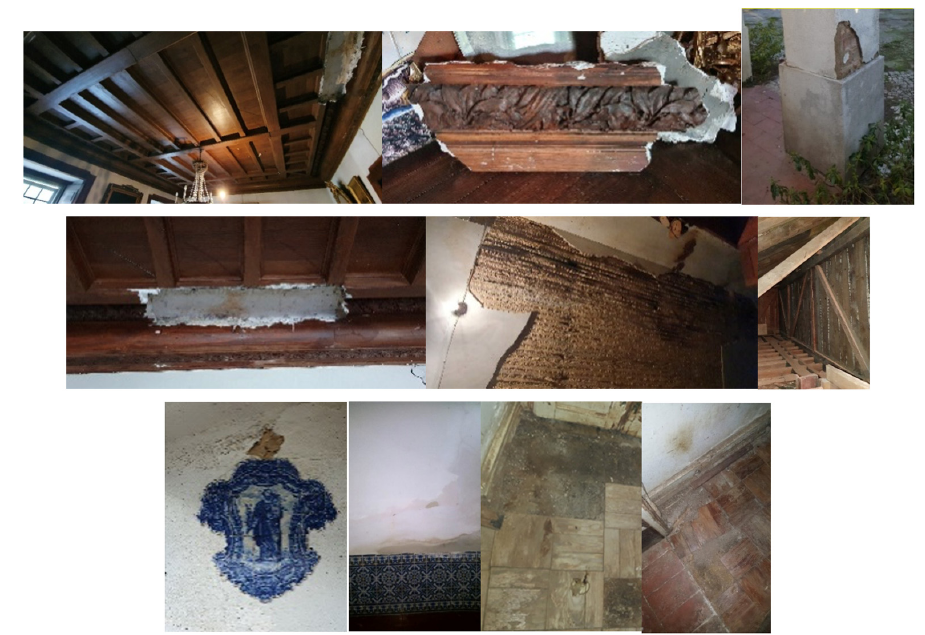
Figure 7. Anomalies found in floor, ceilings, roof, and walls.